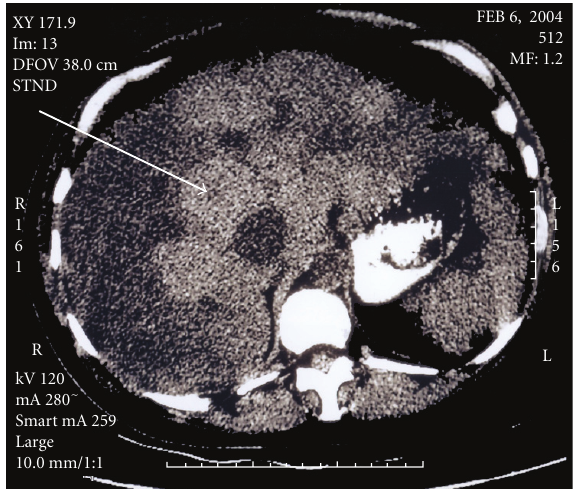
Figure 2: Axial computerized tomography of the abdomen in a liver window demonstrating heterogeneous attenuation of the liver